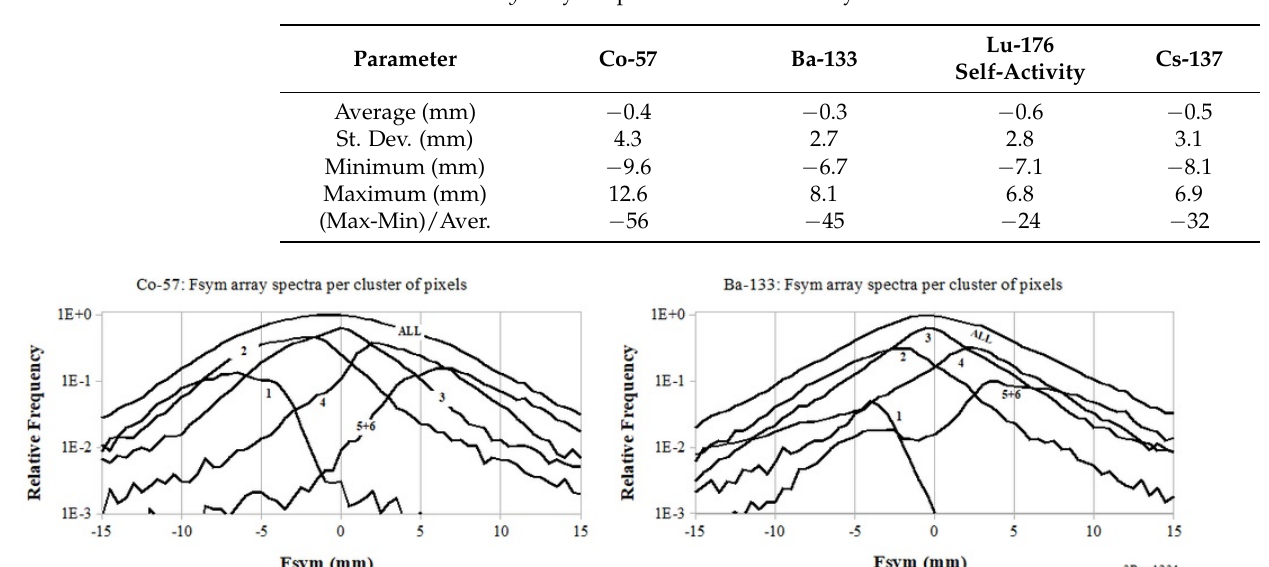
Table 3. Statistics on Fsym crystal-pixel values of the array.